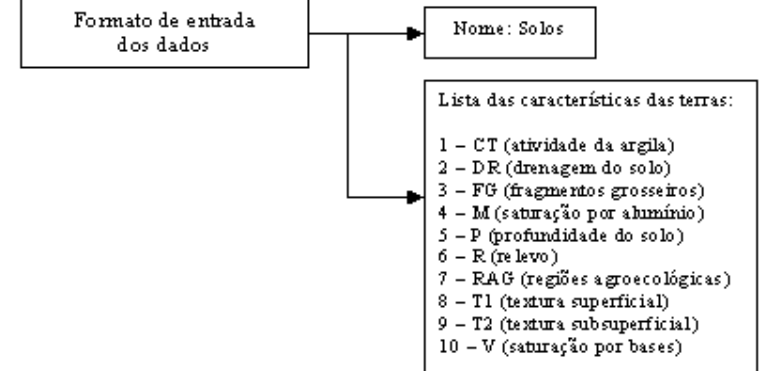
Figura 6. Descrição do formato de entrada dos dados no